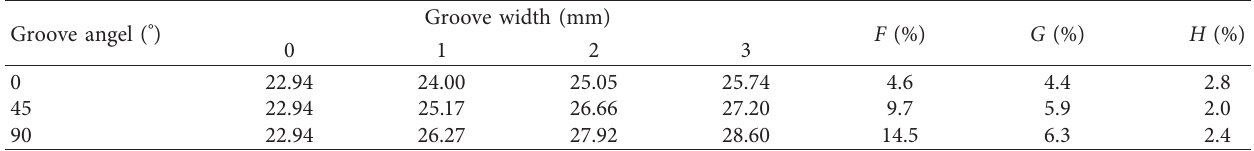
Table 7: Increasing extent of interface friction angle with groove width.